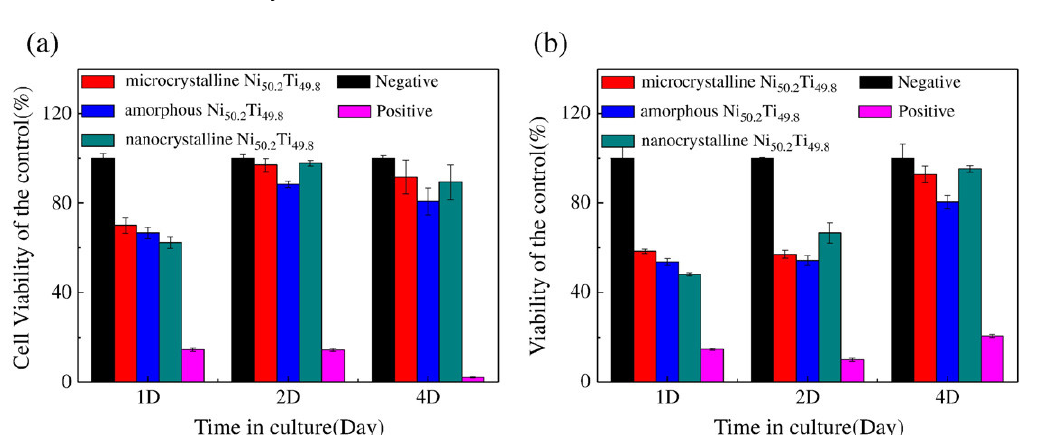
Figure 2. Cytotoxicity of ( a ) L-929 and ( b ) MG63 cell lines co-cultured with extracts from micro- crystalline Ni 50.2 Ti 49.8 , and nanocrystalline Ni 50.2 Ti 49.8 . Reprinted with permission from Ref. [44]. Copyright 2010, Elsevier.